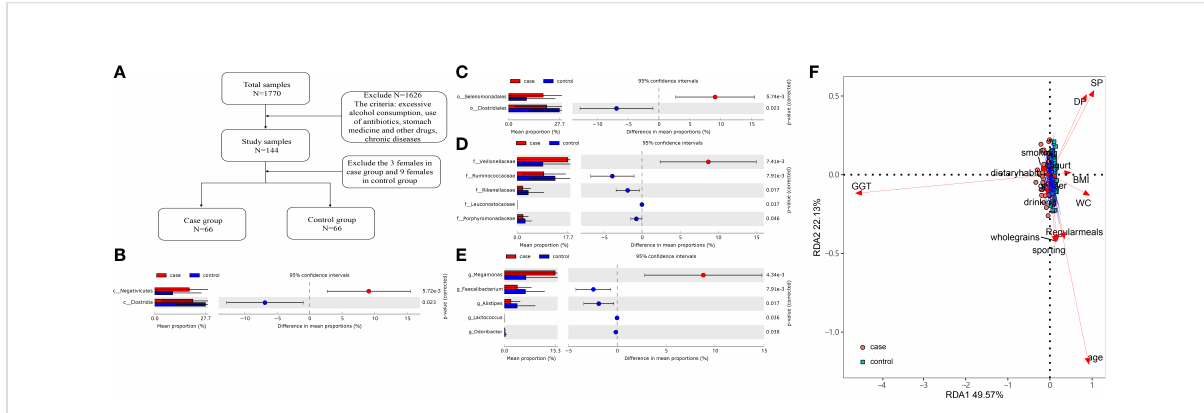
FIGURE 1 (A) Flow diagram. (B – E) Differences at the level of class, order, family, and genus level. (F) The redundancy analysis (RDA) showed the effect of the gammaglutamyl transpeptidase (GGT) level and individual attributes on